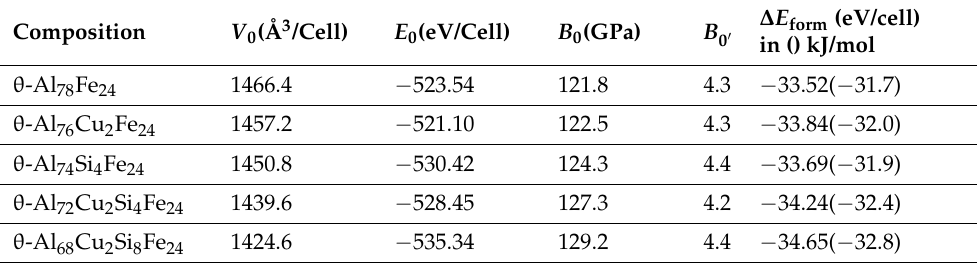
Table 4. The obtained results for the related configurations using the Murnaghan equation of state. V 0 represents the optimized volume, E 0 the energy, B 0 the bulk modulus and B 0 (cid:48) the first derivative. The formation energies ( ∆ E form ) with respects to the elemental solids according to Equation (3) also